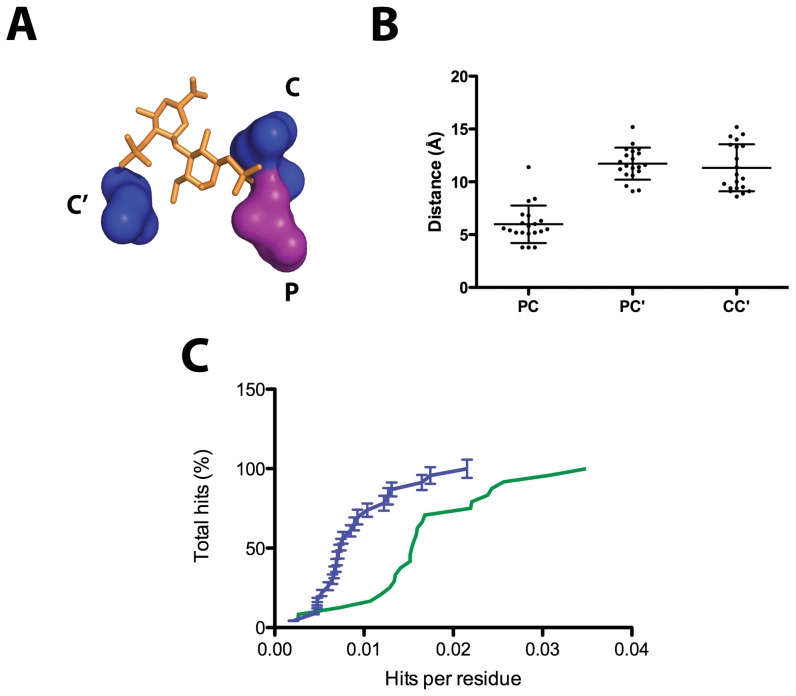
Statistical analysis of the Cα and side chain center of gravity distances between the amino acids conforming the CPC clip motif.(A) Schematic representation of the CPC clip motif, composed of one polar (P) and two cationic residues (namely C and C′, being C the closest to the polar residue). Image was generated with Pymol. (B) Measured PC, PC′ and CC′ distances for the 20 reference proteins described. (C) Enrichment of CPC clip motif in heparin-binding proteins. The negative and positive testing databases were analyzed by SPASM and a cumulative frequency histogram plotting the number of hits per residue is depicted. The positive testing dataset is colored in green and the negative dataset in blue. Each point in the negative dataset represents the average of five independent tests and errors bars are depicted. See the Materials and Methods section for further information.